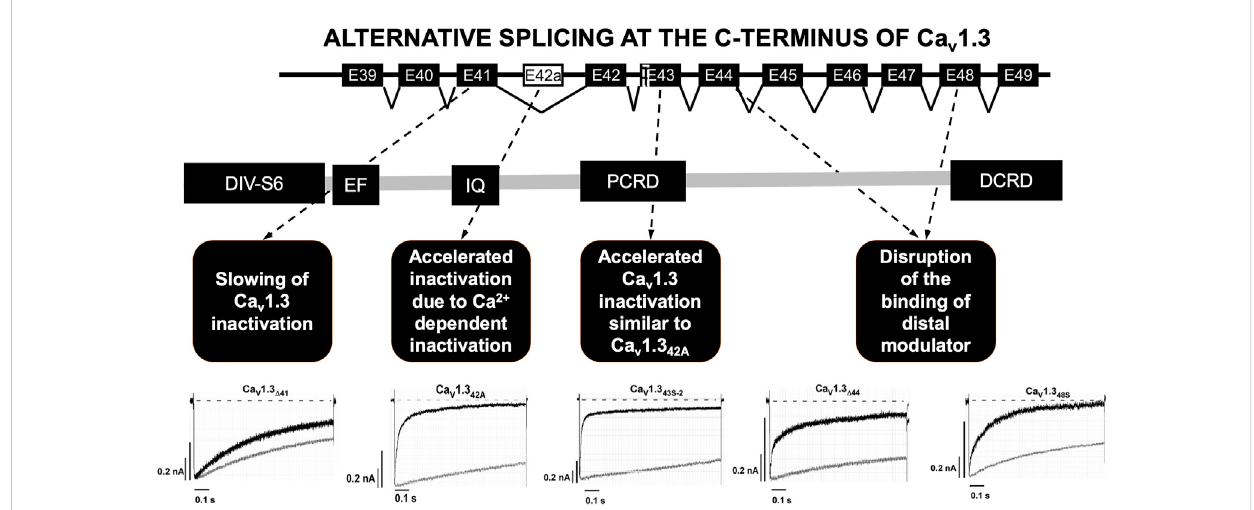
FIGURE 2 Alternative splicing at the C-terminus of Ca v 1.3. Alternative splicing of exon 41 that removes the IQ motif resulted in a truncated Ca v 1.3 protein with diminished inactivation. Splicing of exon 43 which causes a frameshift variant and is susceptible to accelerating the inactivation similar to Ca v 1.3 42A . Ca 2+ currentthroughCa v 1.3 42A channels increasedatnegativevoltages, andinactivation wasfasterbecause ofCa 2+ -dependentinactivation.Splicingofexons 44and48wasanin-framevariantandcauseddisruptionofthebindingofdistalmodulatortotheIQdomain.PCRD(proximal C-terminal regulatory domain), DCRD (distal C-terminal regulatory domain). Current tracing are from reference Tan et al.,